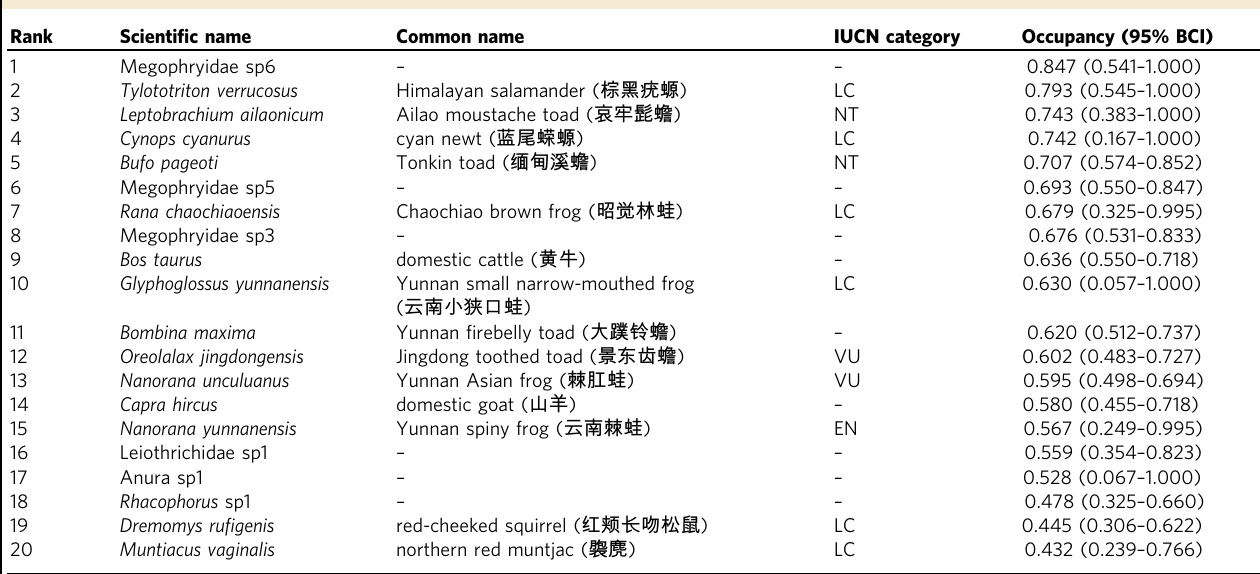
Occupancy represents the posterior mean for the fraction of patrol areas occupied by each species, with 95% Bayesian con fi dence intervals (BCIs) shown in parentheses. Taxonomic information and IUCN Red List category are based on classi fi cation generated by PROTAX. Supplementary Data 1 provides a complete list of species. IUCN categories: LC least concern, NT near threatened, EN